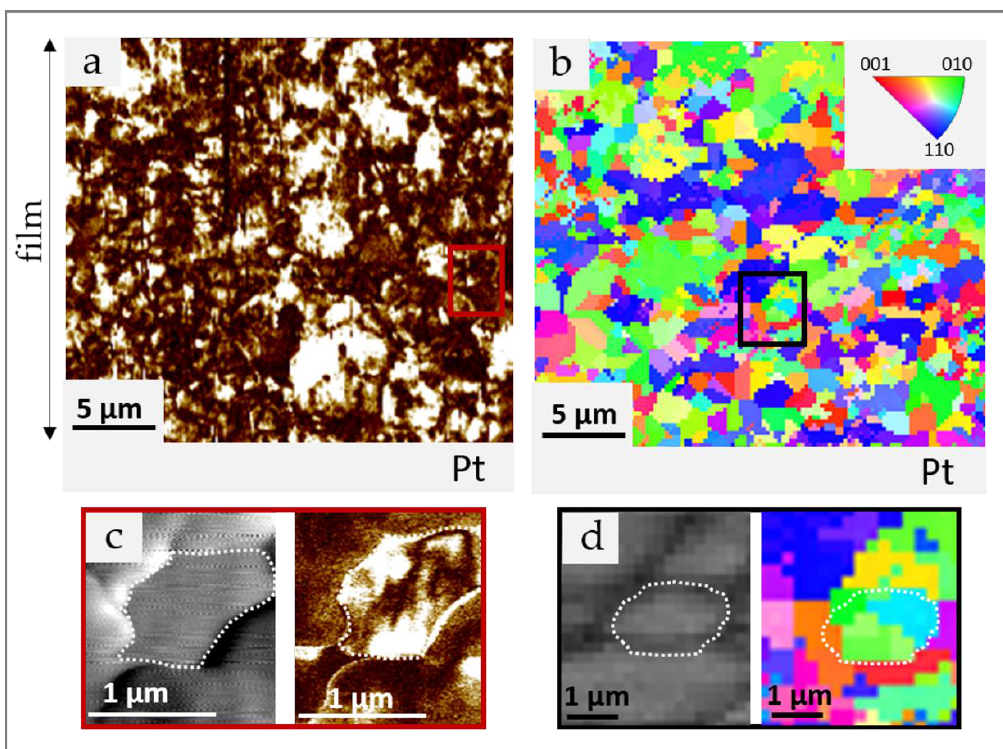
Figure 3. ( a ) Out of plane amplitude PFM image and ( b ) EBSD orientation map with the corresponding colour-key inverse pole figure legend of thick film sintered in O 2 without any PP in cross sectional view, ( c ) topography and out-of-plane PFM amplitude image, and ( d ) band contrast image and EBSD map showing multidomain grains. Grain boundaries are marked by the white dashed line.